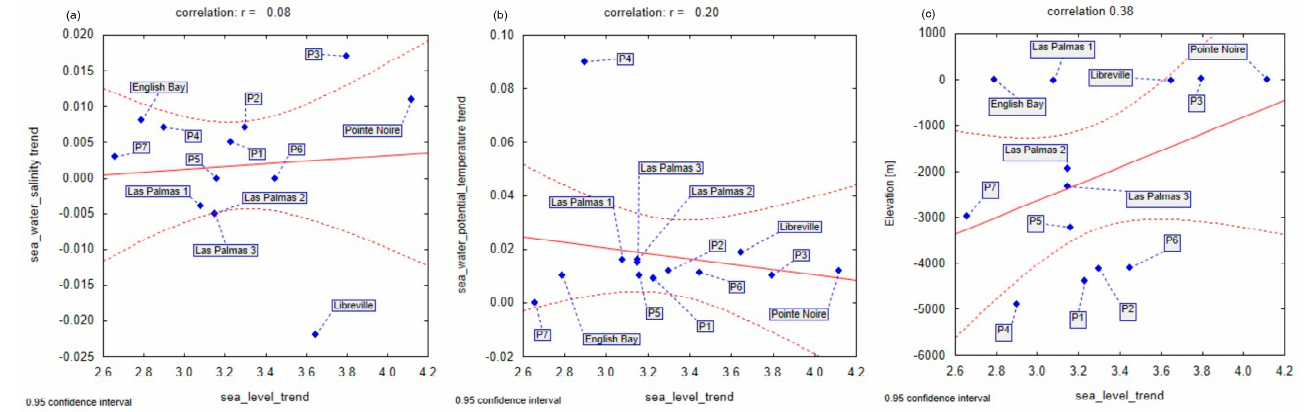
Figure 7. The correlation coefficients for ( a ) sea level trend and sea water salinity trend, as well as ( b ) sea level trend and sea water potential temperature trend and ( c ) sea level trend and elevation of the terrain. Blue rhombs-dispersion plot; area marked by red dashed lines—95% confidence interval of the regression line.